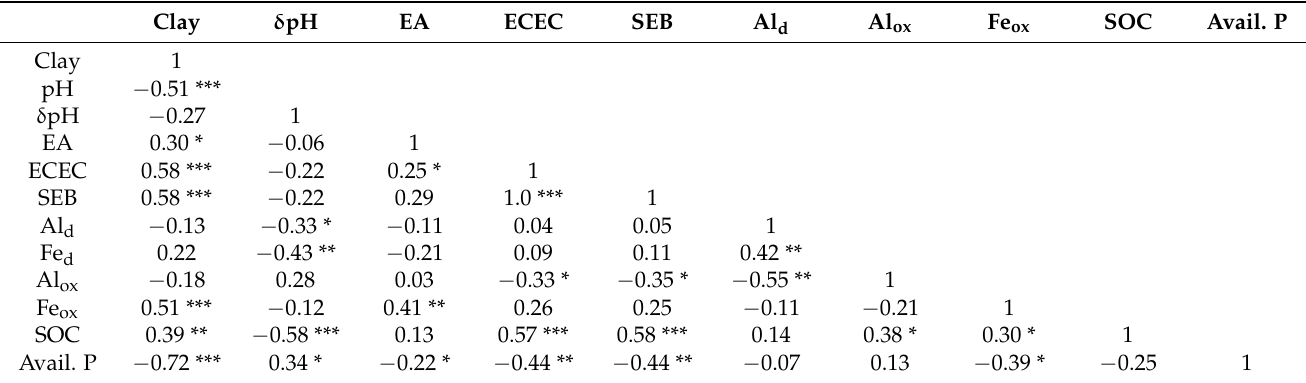
Table 5. Pearson and Spearman correlation coefficients for the Adansam soils.